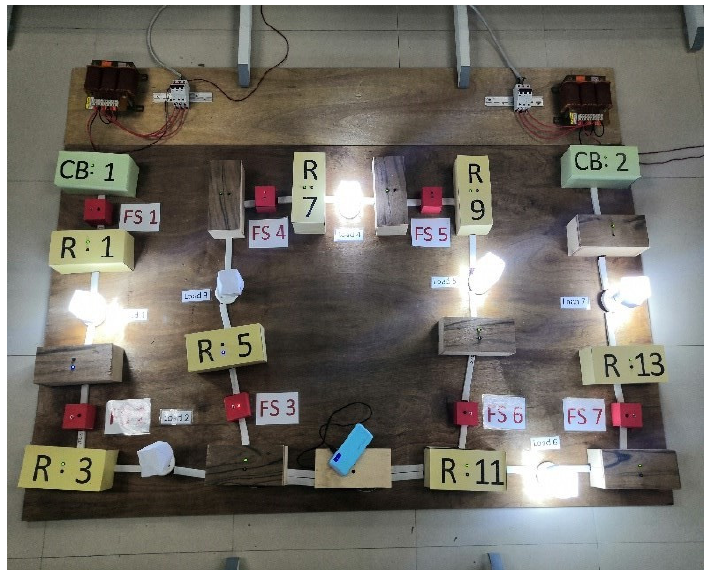
Figure 19. Hardware prototype with faults on Lines 5 and 7.